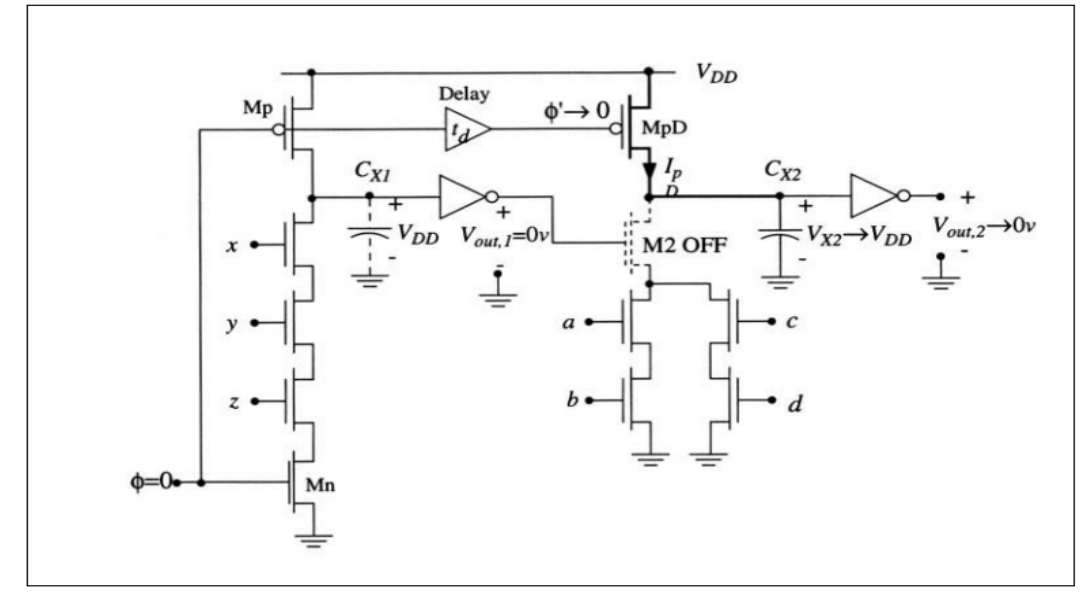
Figure 13. High-speed cascade circuit.